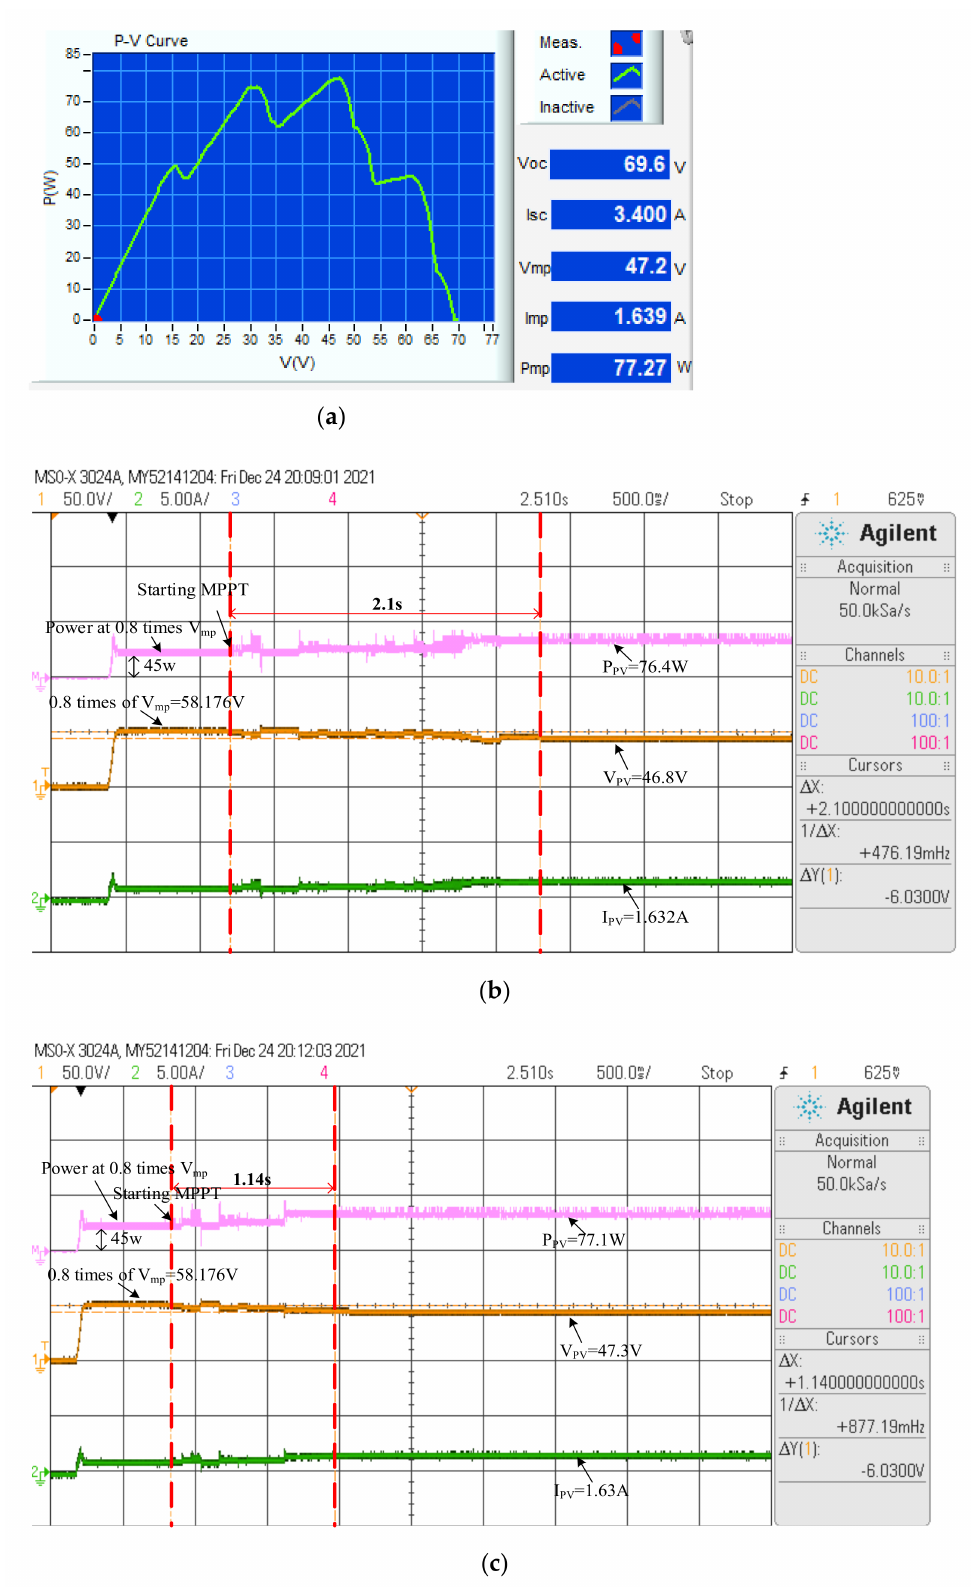
Figure 20. Test results of the MPPT of photovoltaic module array in Case 5: ( a ) P-V characteristic curve; ( b ) tracking curve of the traditional ABC algorithm ( P mp = 76.4 W); ( c ) tracking curve of the I-ABC ( P mp = 77.1